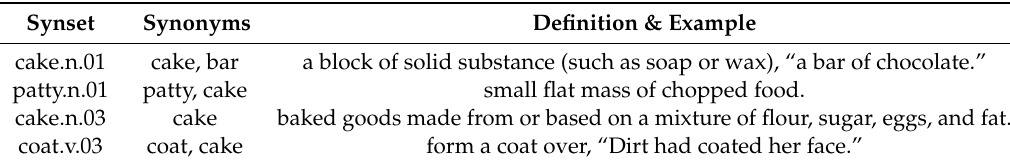
Table 1. Synsets of